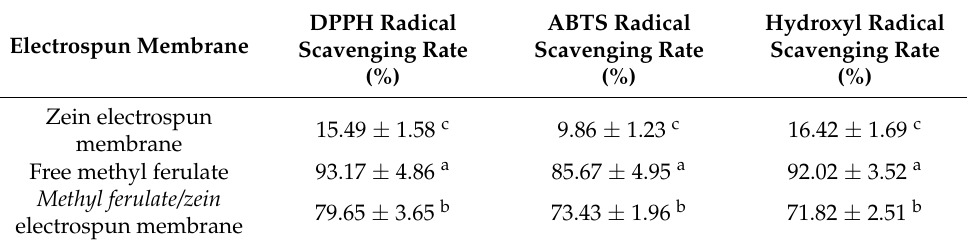
Table 2. Verification of antioxidant activity of fiber membrane.